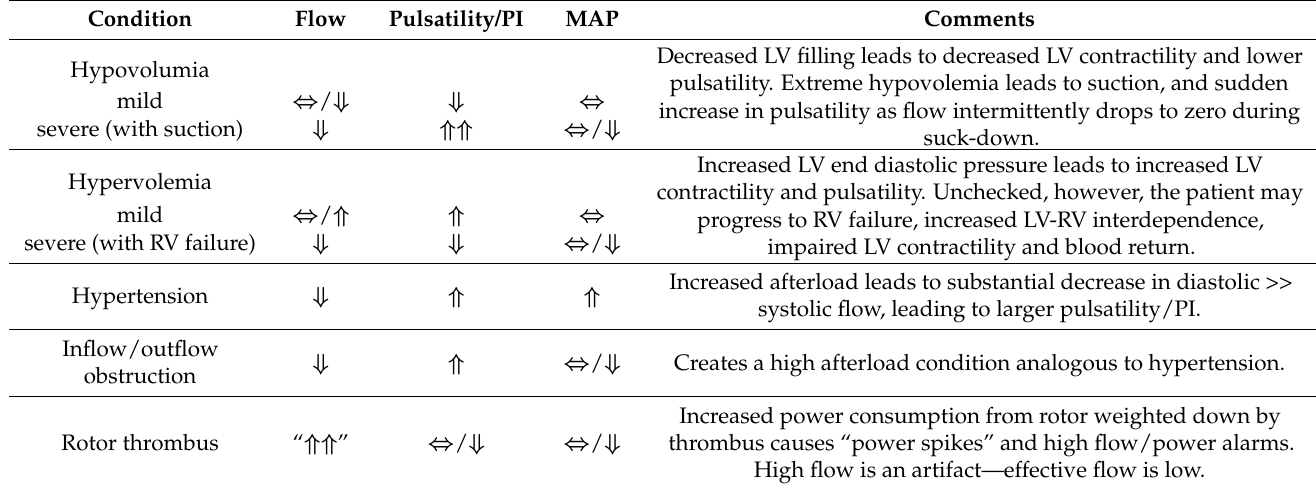
Figure 4. Device thrombus. A controller console showing an illustrative example of left ventricular assist device (LVAD) thrombosis in an HVAD system. Note the time scale of 14 days on the x-axis. This patient developed acute thrombosis at the inflow cannula 13 days ago, leading to dramatically increased afterload (increased effective gradient between left ventricle and aorta) and decreased LVAD flow ( A ). The thrombosis partially broke up over the next 7 days. Five days ago, the pump speed was increased with minimal effect on flow ( B ). Two days ago, the thrombus suddenly dislodged and was ingested by the rotor, causing a “power spike” ( C ), followed by return of baseline pump function. This patient tolerated these events well and went on to receive a heart transplant. Table 1. Parameters in selected physiologic states for centrifugal-flow